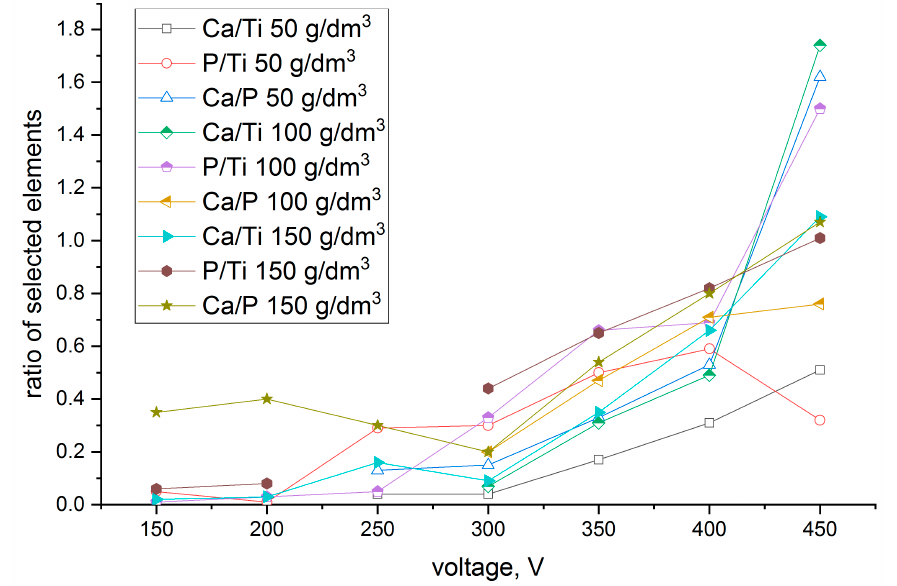
Figure 1. Constituent element ratios as a function of the voltage applied during the plasma electrolytic oxidation (PEO) process and concentration of hydroxyapatite in the anodizing bath. The results are presented as an average of the element content determined from the measured surface area (measurement repeated three times).